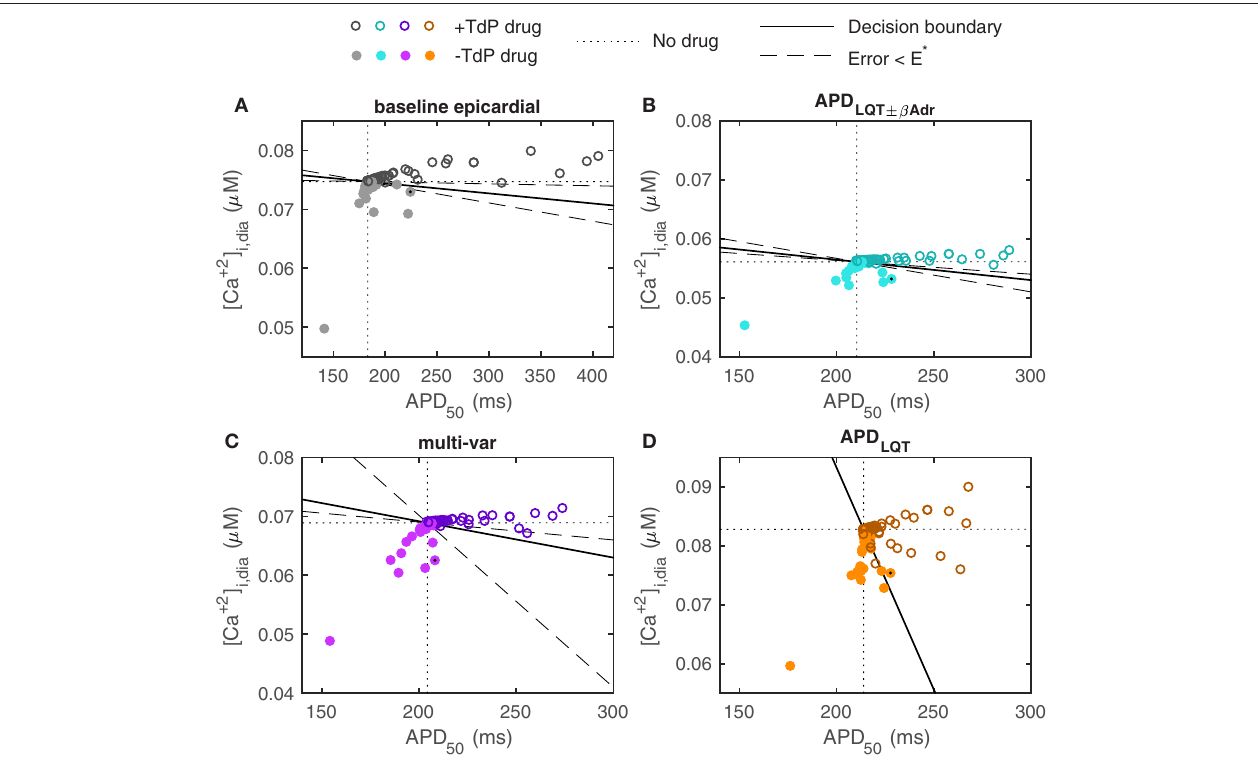
FIGURE 4 | Prediction of TdP risk from model simulations. (A) Baseline ORd model with epicardial myocyte parameter settings (the epicardial configuration is shown here as it was determined to give the best classification in Lancaster and Sobie, 2016. Using the endocardial baseline model yields very similar results). (B) APD LQT ± β Adr optimized model. (C) Multi-variable optimized model. (D) APD LQT optimized model. Dotted lines indicate no-drug control values of APD 50 and diastolic [Ca 2 + ] i . Colors for the different models correspond to the color scheme in Figure 3 . Solid lines give decision boundaries between torsadogenic (open circles) and non-torsadogenic drugs (filled circles). Dashed lines demarcate regions within which the categorization error remains below a threshold value (E*). Using the multi-variable optimized model, all drugs that prolong APD 50 by more than 5 ms are known TdP risk drugs. Verapamil (marked by black dot) is an example of a TdP negative drug that significantly prolongs the AP in the baseline and APD-optimized models but not in the multi-variable optimized